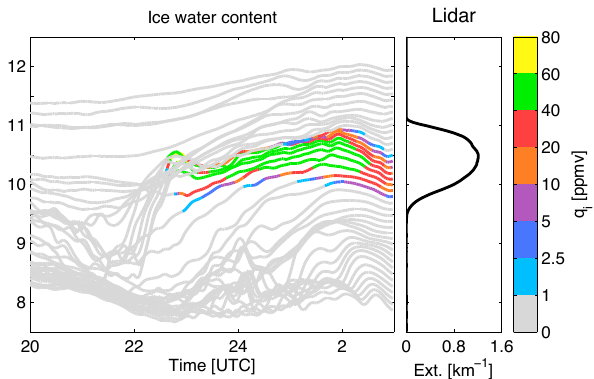
Figure A2. Ice water content from the ZOMM simulation along the trajectories.